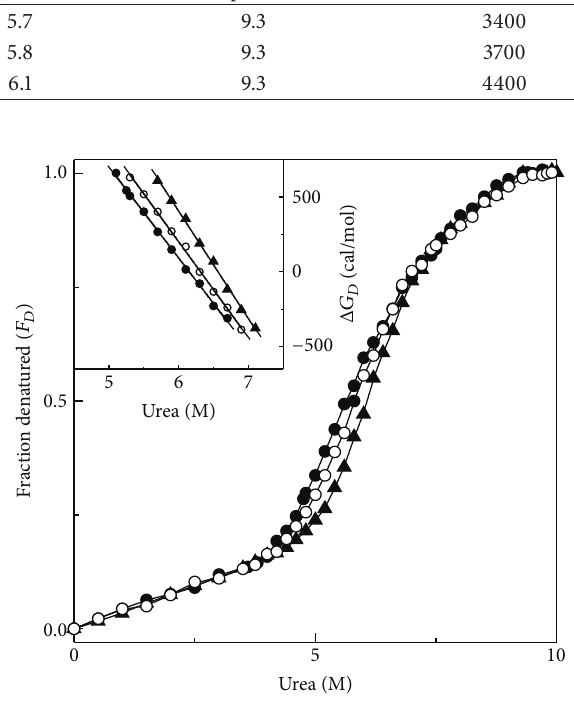
Figure 3: Normalized transition curves of urea-induced denatu- ration of FITC-BSA both in the absence ( e ) and presence of 10% ( I ) and 20% ( 󳵳 ) (w/v) honey as monitored by FITC fluorescence at 522 nm upon excitation at 495 nm. Inset shows dependence of Δ𝐺 𝐷 of FITC-BSA on urea concentration in the absence ( e ) and presence of 10% ( I ) and 20% ( 󳵳 ) (w/v)